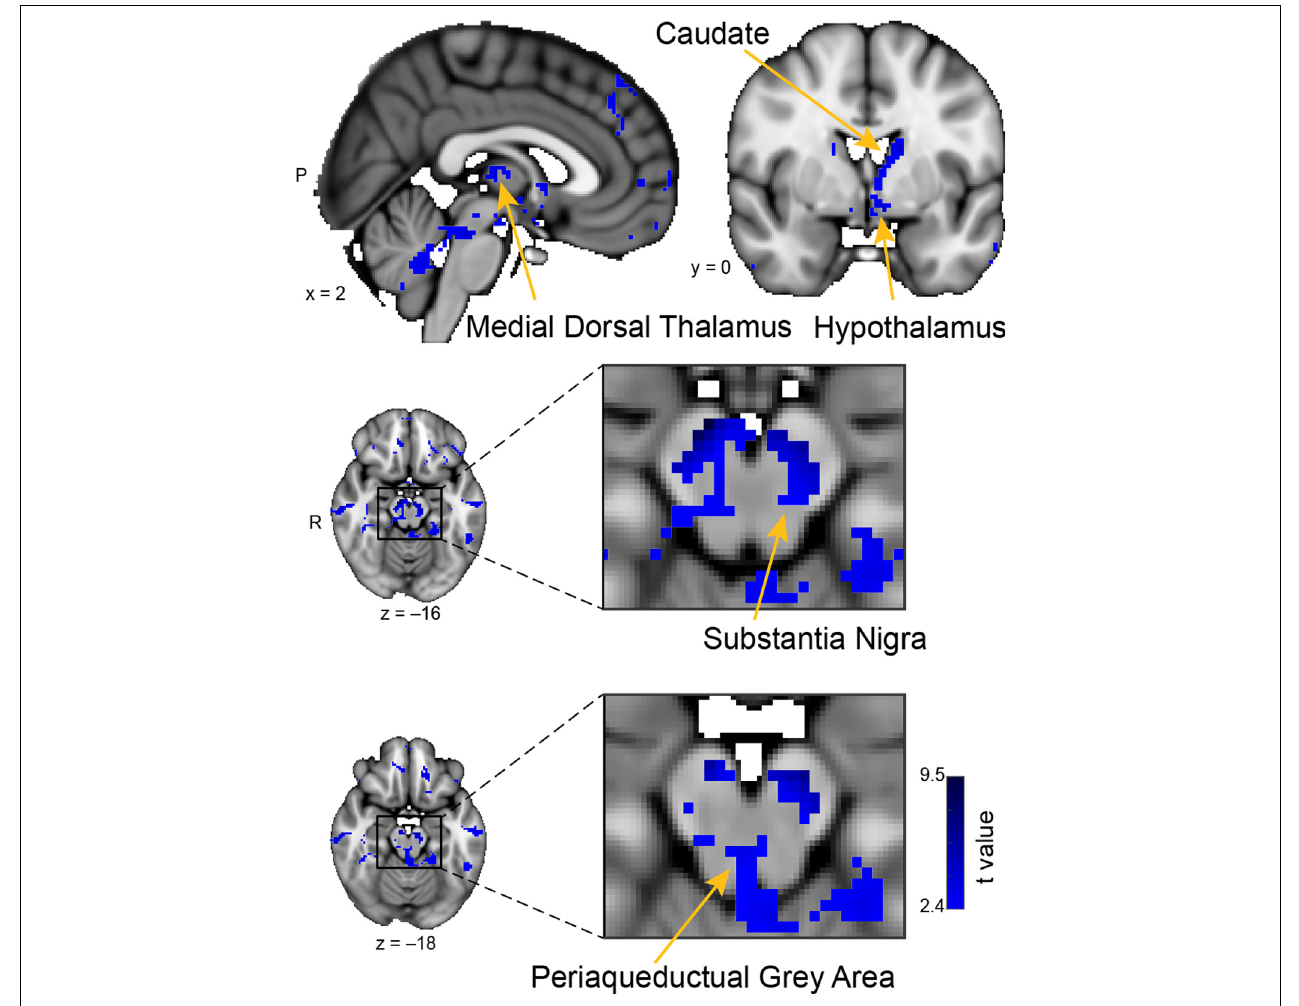
FIGURE 5 | Whole-brain resting connectivity of the CoA. Regions of interest include the hypothalamus, substantia nigra, periaqueductal gray area, and medial dorsal thalamus. The connectivity map was thresholded at threshold-free cluster enhancement corrected P < 0.05. Results are overlaid on FSL’s MNI152_T1_1